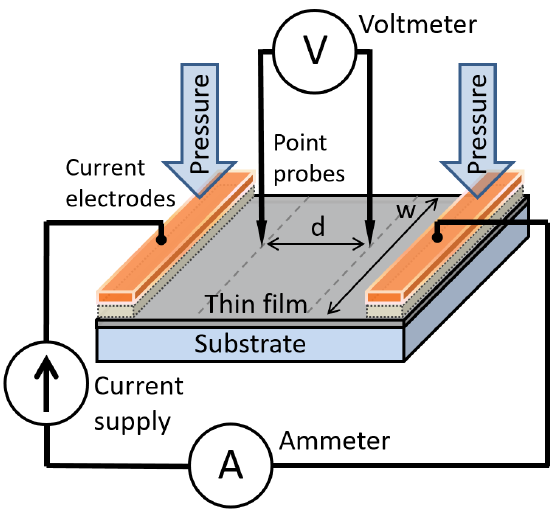
Figure 5. Scheme of the four-probe setup used for thin film measurements.